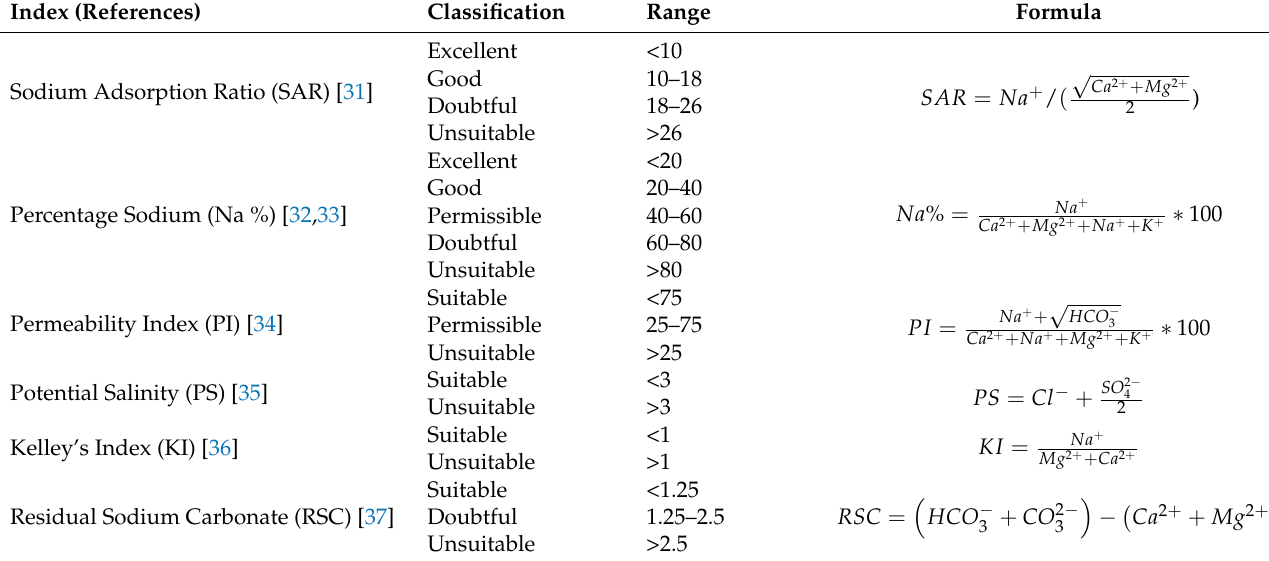
Table 1. Different approaches to the assessment of hydrochemical